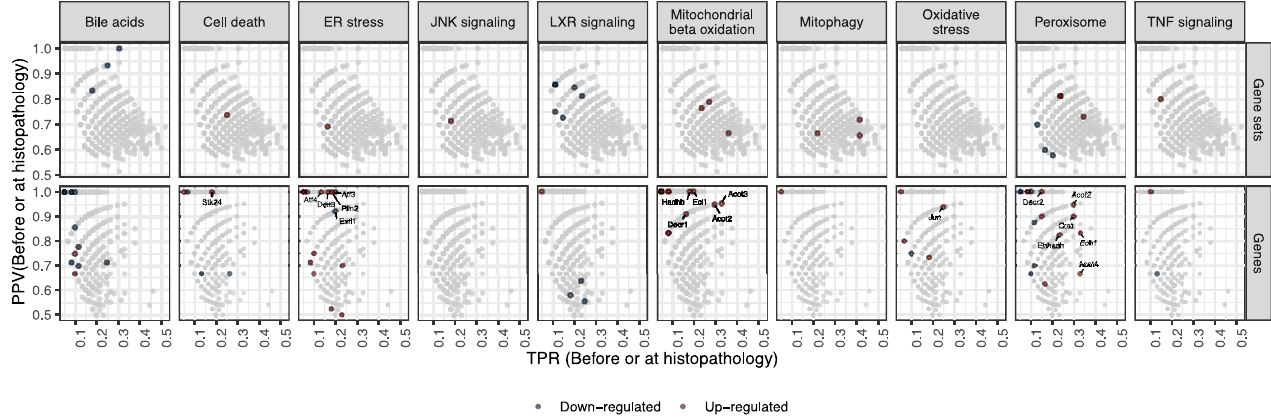
Fig 6. True positive rate (TPR) and positive predictive value (PPV) before or at histopathology of genes and gene sets in known key events in DILI. Events related to the given known key event are shown in red or blue indicating an up- or downregulation, respectively. Genes with a p-value < 0.0001 involved in known key events in DILI are additionally labelled. The background distribution of all significantly enriched genes or gene sets is shown in grey (p- value < 0.05).